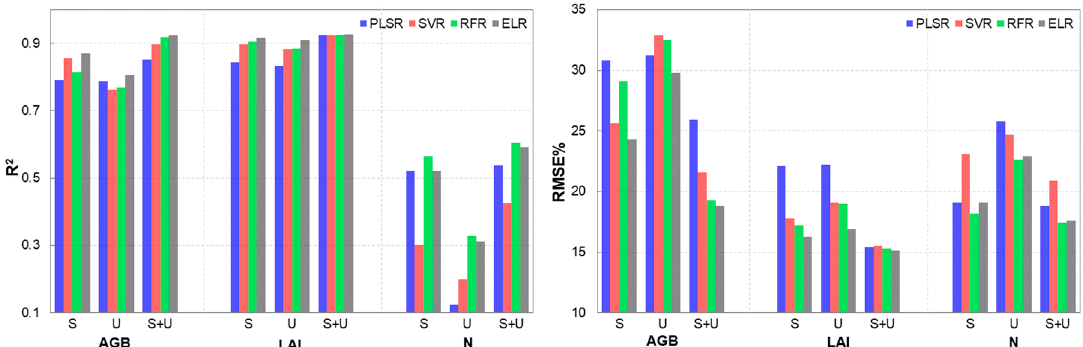
Figure 12. R 2 and RMSE% of AGB, LAI, and N estimation with PLSR, SVR, RFR, and ELR methods using satellite, UAV, and both satellite and UAV data, respectively. S represents satellite data, U represents UAV data, and S+U stands for the combination of satellite and UAV data. ELR outperformed other methods in AGB and LAI estimation, and RFR produced the best results for N estimation.